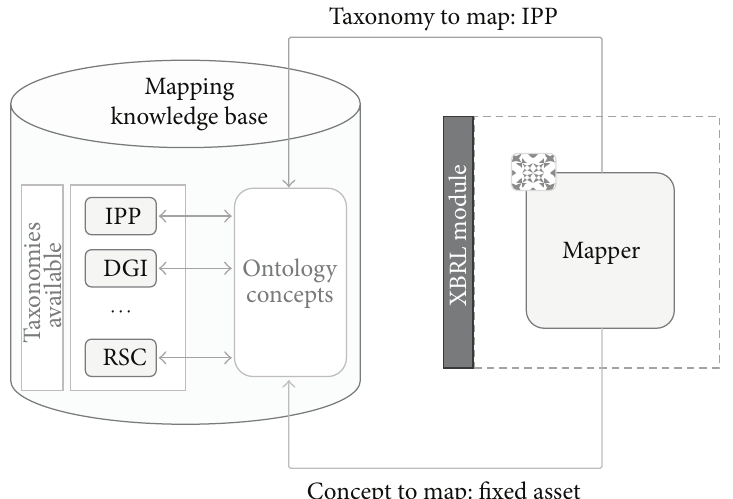
Figure 10: Mapping